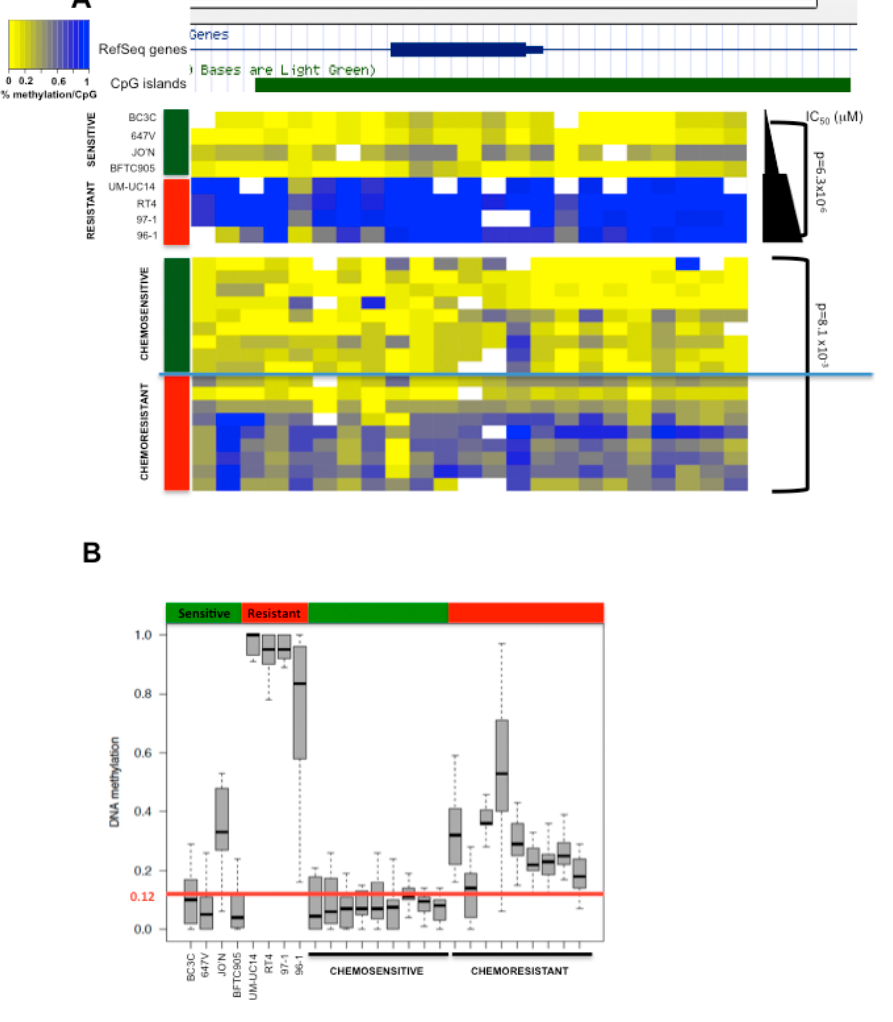
Figure 3. HOXA9 promoter methylation is associated with chemoresistance of human muscle-invasive bladder cancer tissue. ( A ) CpG methylation at the HOXA9 promoter is increased in resistant compared to sensitive tumor samples. Methylation quantification of tumor samples was carried out using the EpiTYPER assay; ( B ) Based on methylation levels detected in the cisplatin sensitive cell lines, a cut-off methylation level of 12% was defined as predictive of cisplatin resistance. Resistant tumor samples ( n = 9) show methylation levels >12% ( p < 0.001).